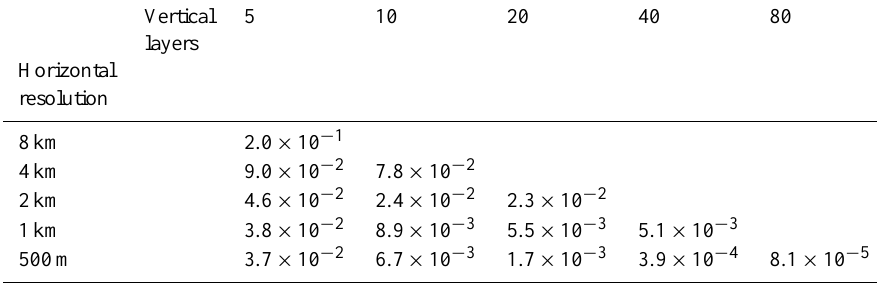
Table 4. Relative errors for the GIS mesh convergence study with uniform vertical spacing.